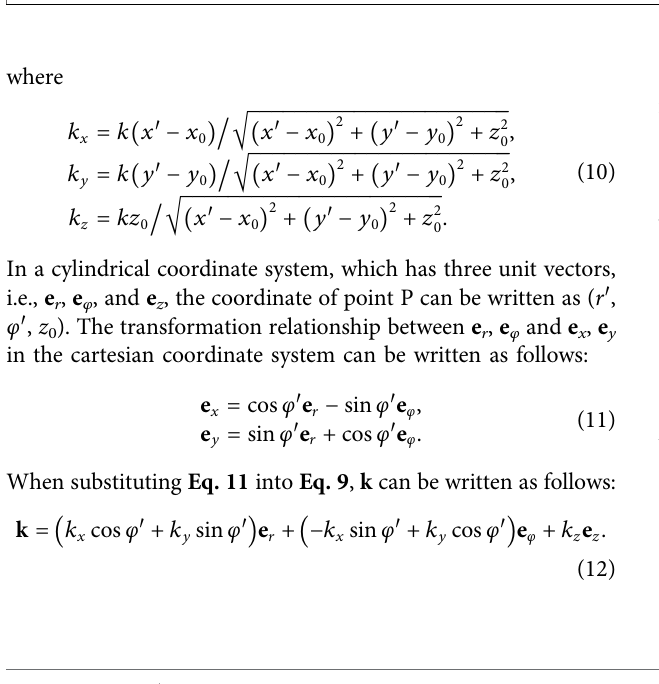
FIGURE 6 | Focusing sketch diagram of a light ray for a vortex beam. The light ray propagates from the initial point A to point P and is then de fl ected by lens and arrives at point B.